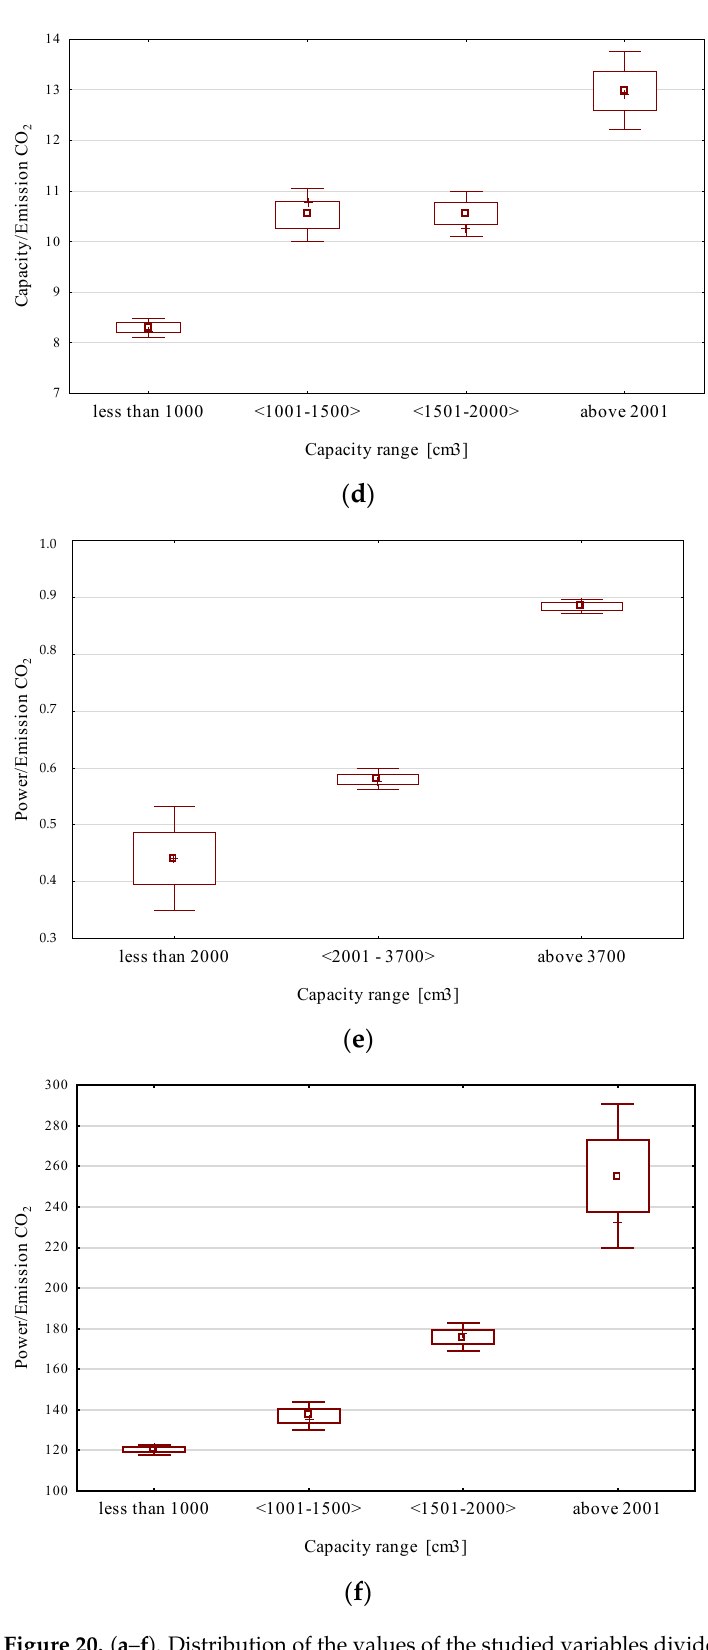
Figure 20. ( a – f ). Distribution of the values of the studied variables divided into categories of capacity range [cm 3 ]. Source: Developed own.